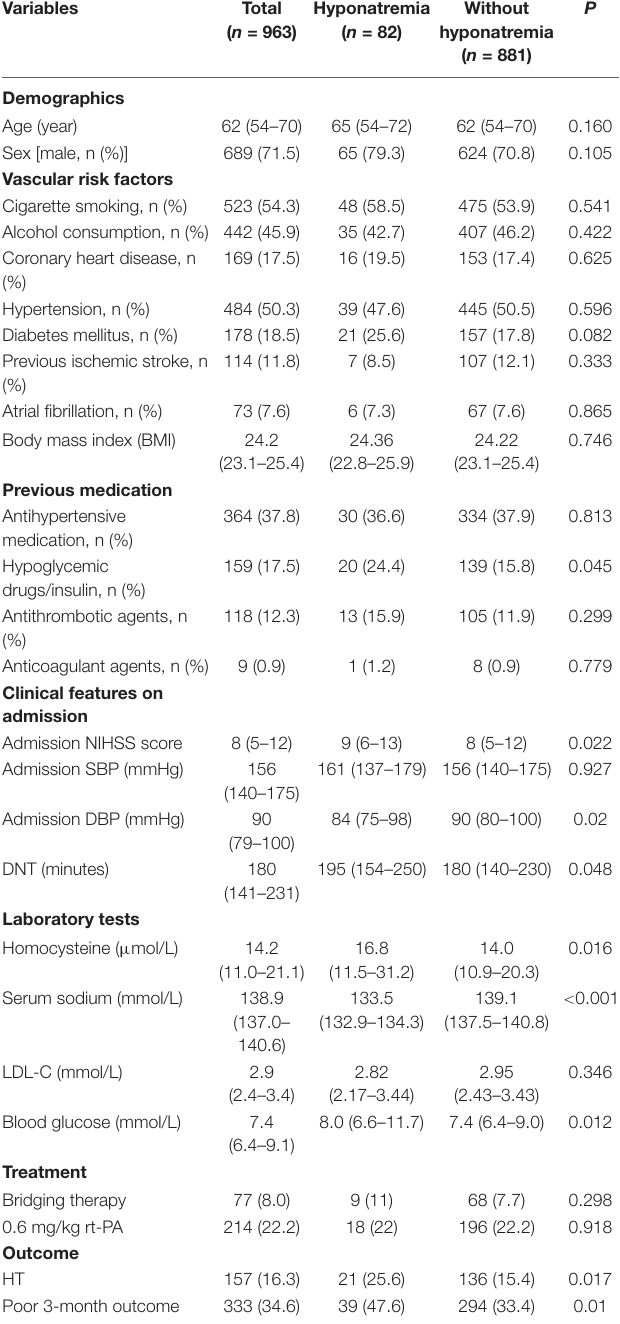
TABLE 1 | Baseline characteristics of the patients with and without